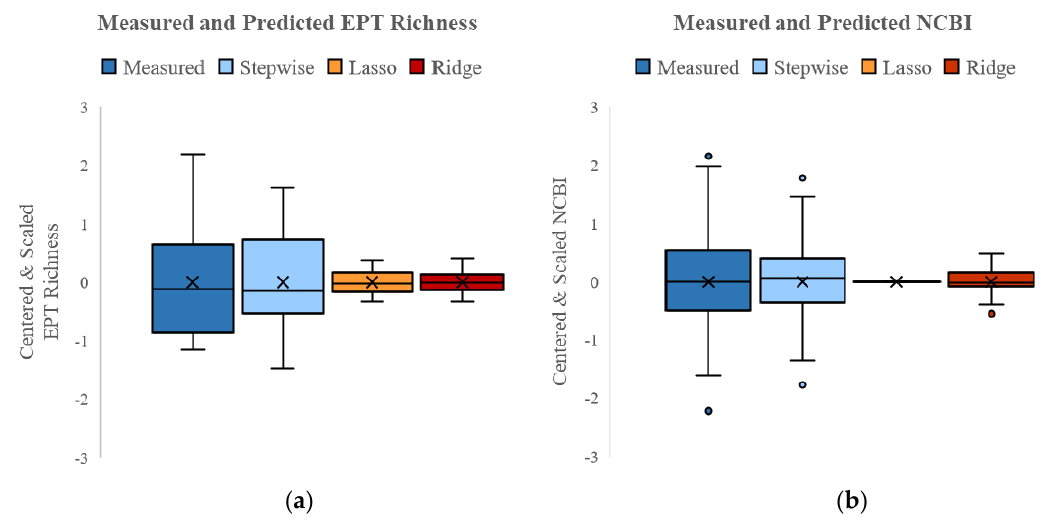
Figure 3. Measured and predicted centered and scaled values for ( a ) EPT richness and ( b ) NCBI for the SQT dataset (n = 34). The “x” indicates the mean value. Table 3. Partial regression coefficients and coefficients of determination (R 2 ) resulting from stepwise, lasso, and ridge with the SQT dataset for EPT richness and the NCBI. Variables with higher weights are in bold ( ≥ |0.20|). Asterisks correspond to values that are statistically significant at applicable alpha levels for stepwise (see below footer).